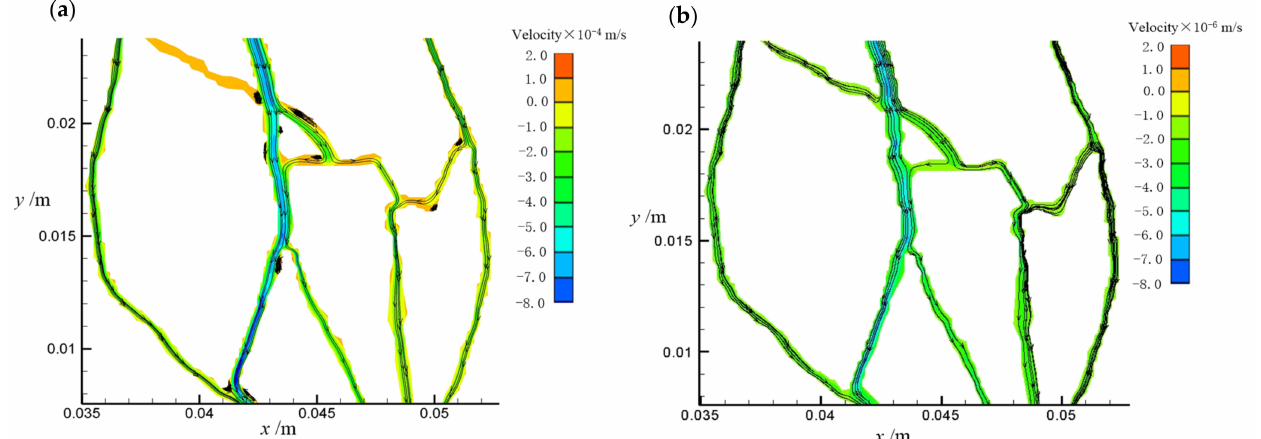
Figure 17. The flow velocity profile and streamlines on cross-section of y = 0.4 at different hydraulic gradients: ( a ) J = 1.0 × 10 − 5 , ( b ) J = 1.0 × 10 − 3